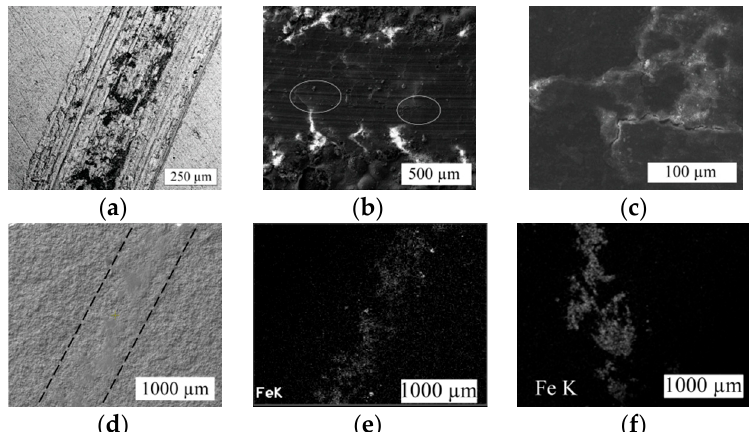
Figure 6. Wear tracks on disks (SEM, front view): ( a ) AISI 420 against H13, backscattered electrons; ( b ) Cracks on worn borided H13 (ball: untreated AISI 420), secondary electrons; ( c ) Same as ( b ), but with borided AISI 420 ball; ( d ) Borided AISI 420 against YSZ, backscattered electrons; ( e ) Same track as ( d ): mapping of iron K α ray signal, ( f ) Similar track on YSZ worn by untreated AISI 420.